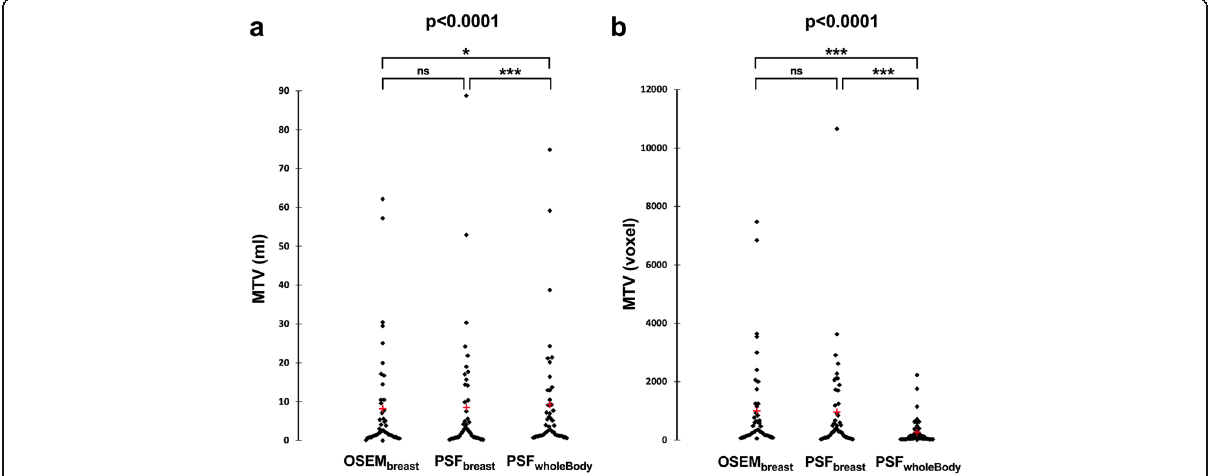
Fig. 1 Paired comparison of OSEM breast , PSF breast and PSF wholeBody metabolic tumour volumes ( a ) and number of voxels within MTVs ( b ). Red cross represents the mean values. Legends for p values: ***< 0.001; **< 0.01; *< 0.05. ns non significant